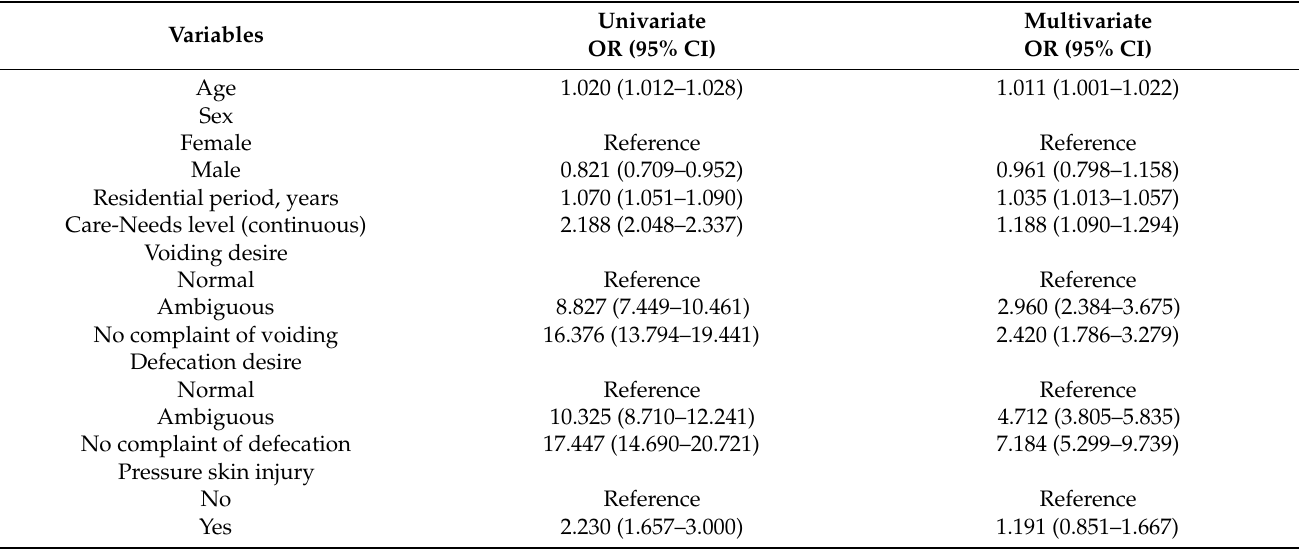
Table 4. Risk factors of double incontinence.